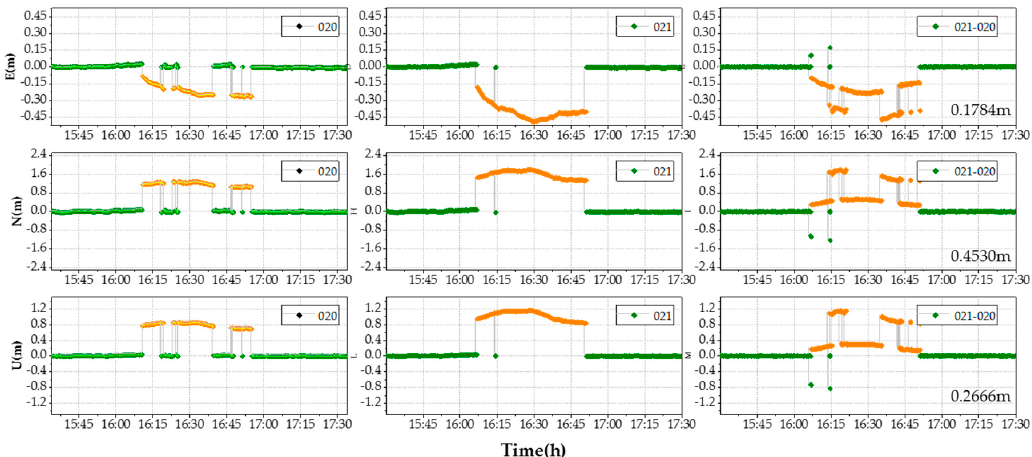
Figure 11. Coordinate bias in ENU (east, north, up) direction: E (top line), N (middle line), and U (up line). The RMS of the coordinate bias in the top right corners at right column: DOY 020 (left column), DOY 021 (middle column), and after correction of the SF model (right column).